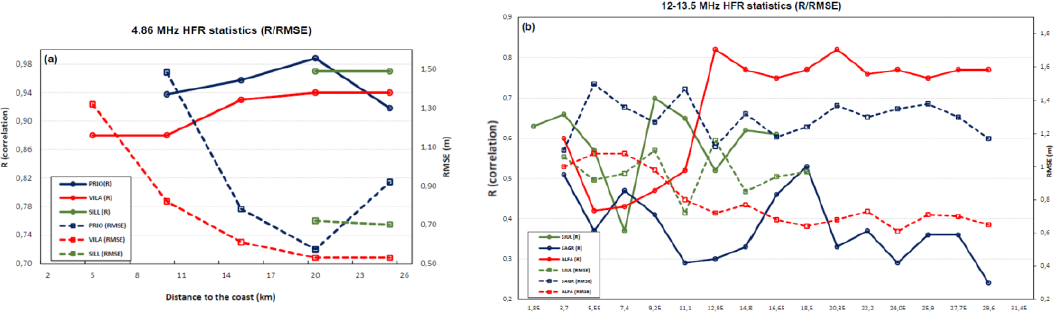
Figure 12. Root-mean-squared error (RMSE) and correlation (R) between HFR- SRAL SWH measurements as a function of distance to coast (km). ( a ) 4.86 MHz HFR sites (red: VILA; blue: PRIO and green: SILL); ( b ) 12–13.5 MHz HFR sites (red: ALFA; blue: SAGR and green: SJUL). Dashed lines: RMSE (m) and solid lines: R.